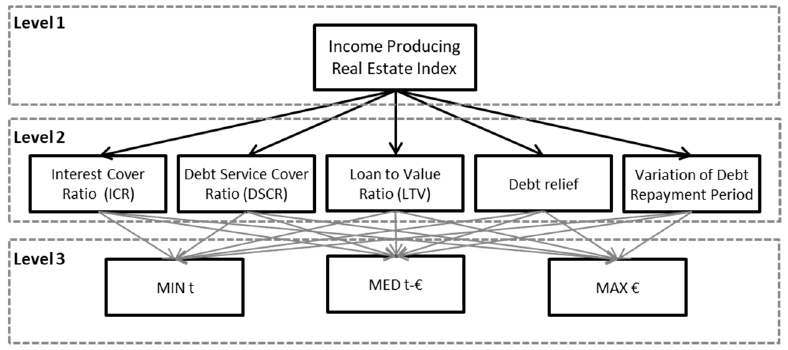
Figure 4. Hierarchy of decision levels for the case study.